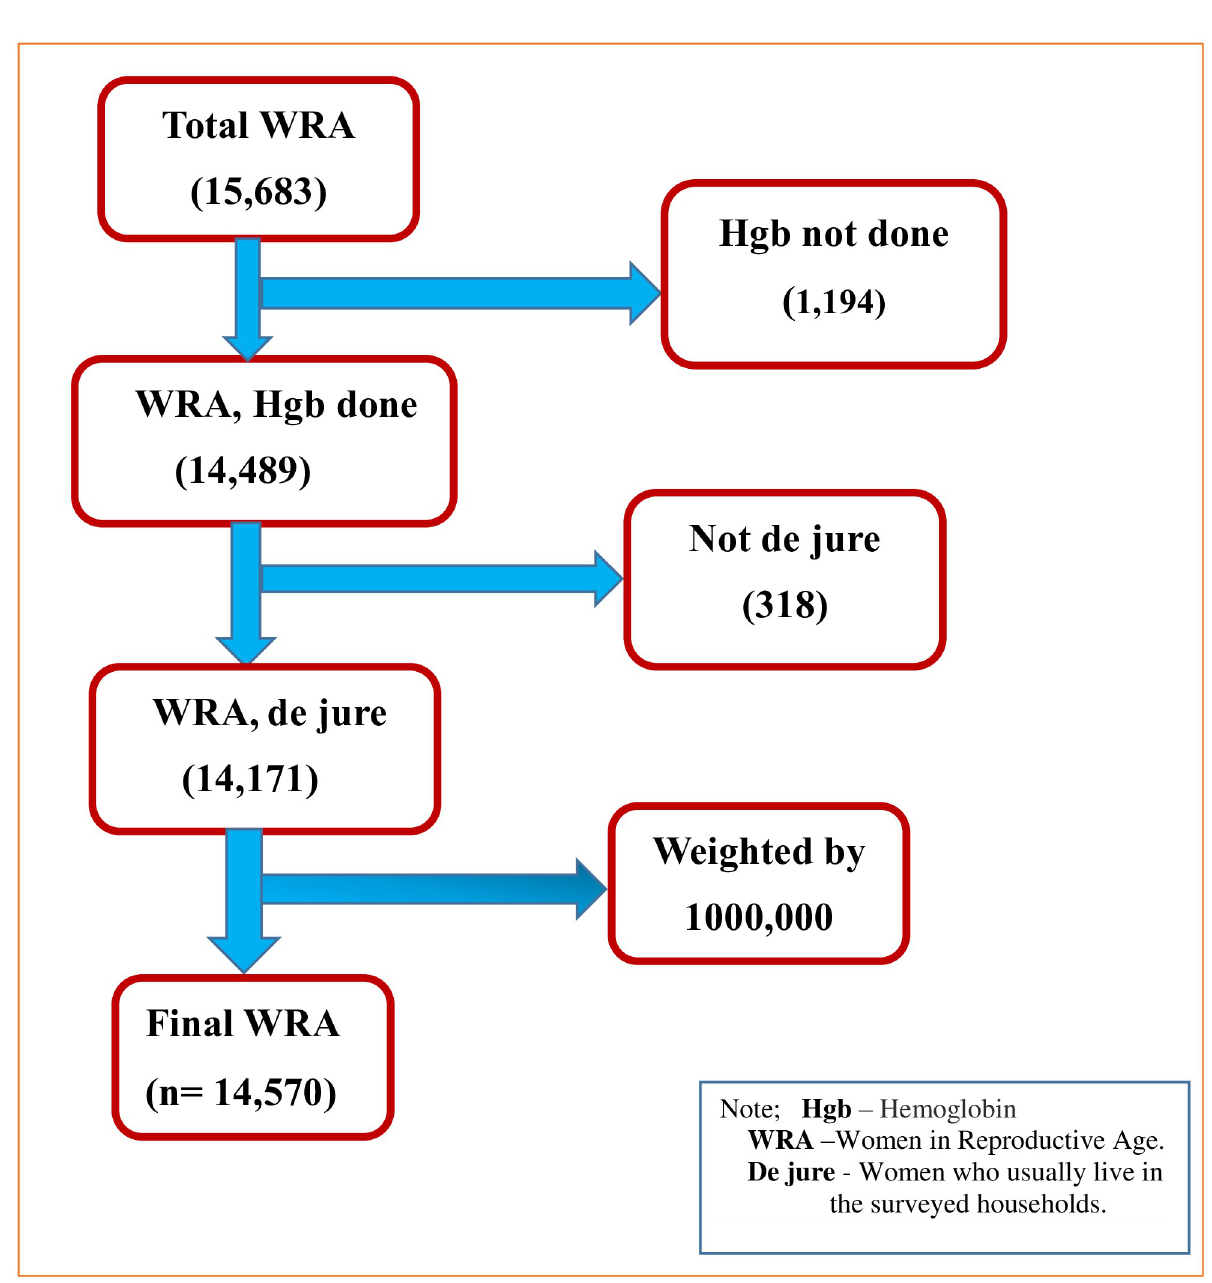
Fig 1. Sampling procedure and sampling technique geographically weighted regression analysis of anemia and its associated factors among reproductive-age women in Ethiopia using 2016